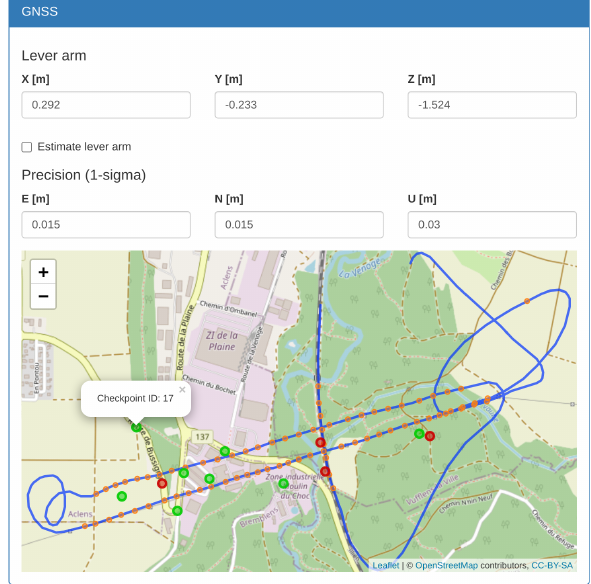
Figure 2. GNSS configuration panel. The GNSS measurements provided as input are displayed on a map as a blue line. If provided, checkpoints and Ground Control Points are displayed as green and red dots, respectively. Approximate image positions are also shown as orange